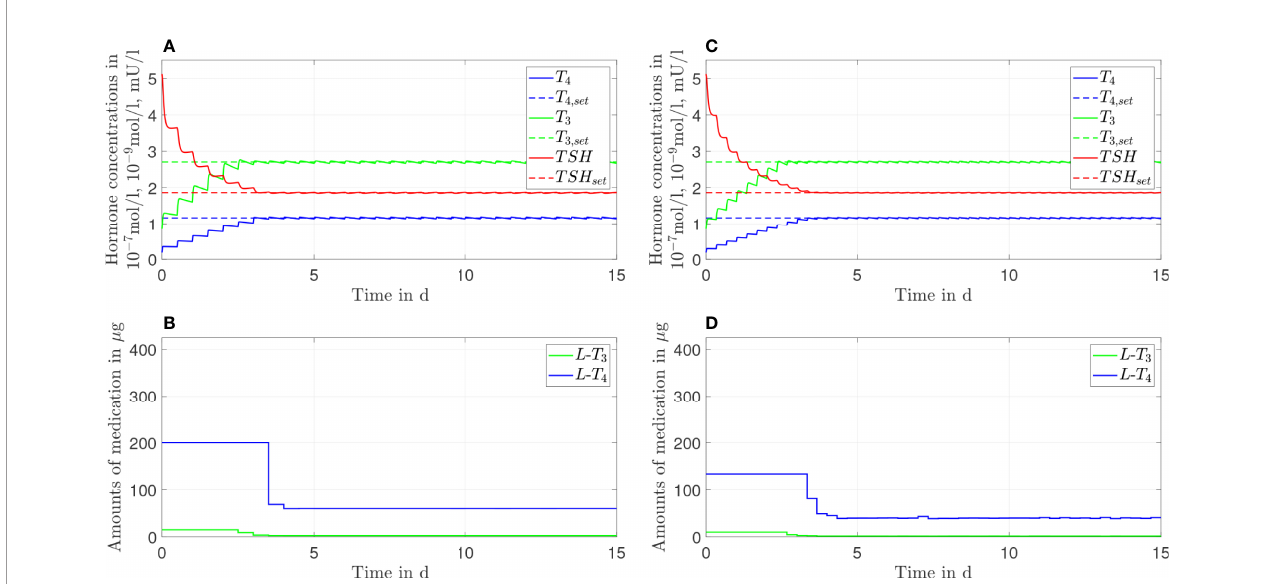
FIGURE 8 | Simulation results of an L-T 3 /L-T 4 combined therapy in which the patient takes in a drug two times (A, B) or three times (C, D) a